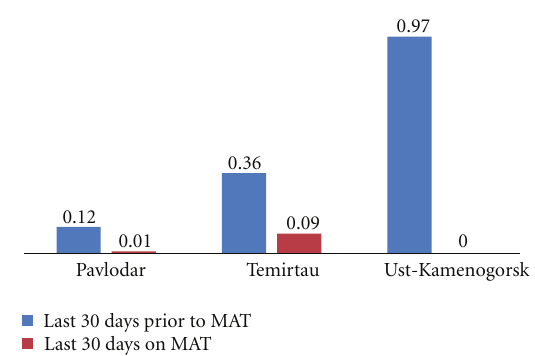
Figure 4: Use of opiates according to mean Opiate Treatment Index scores in patients before and after enrollment into medication assistance therapy, by